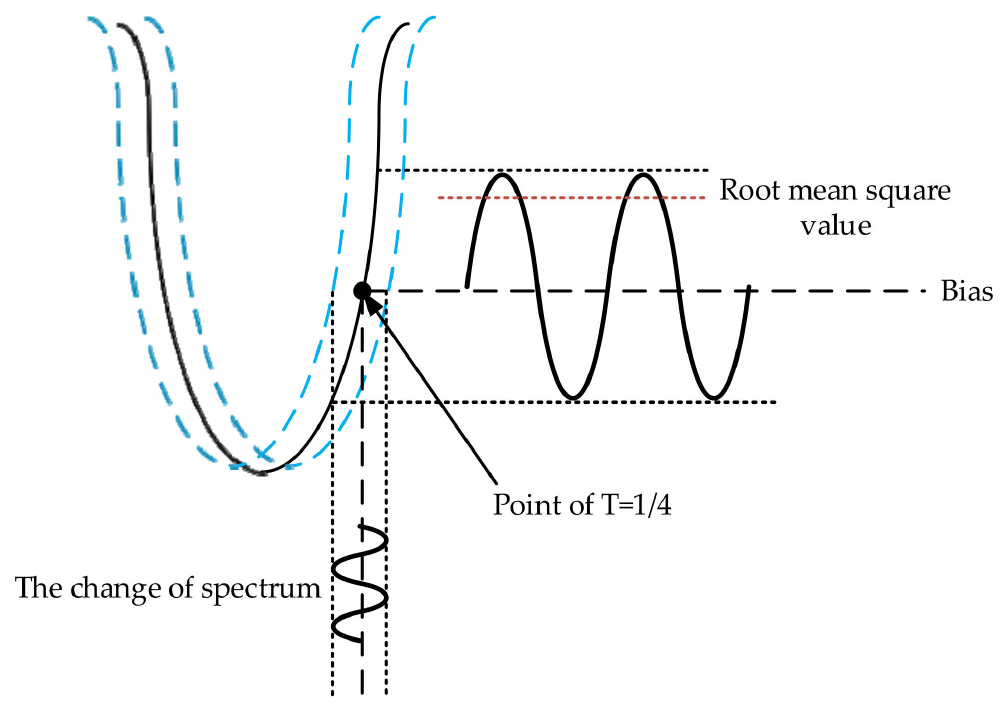
Figure 13. The change in the transmission